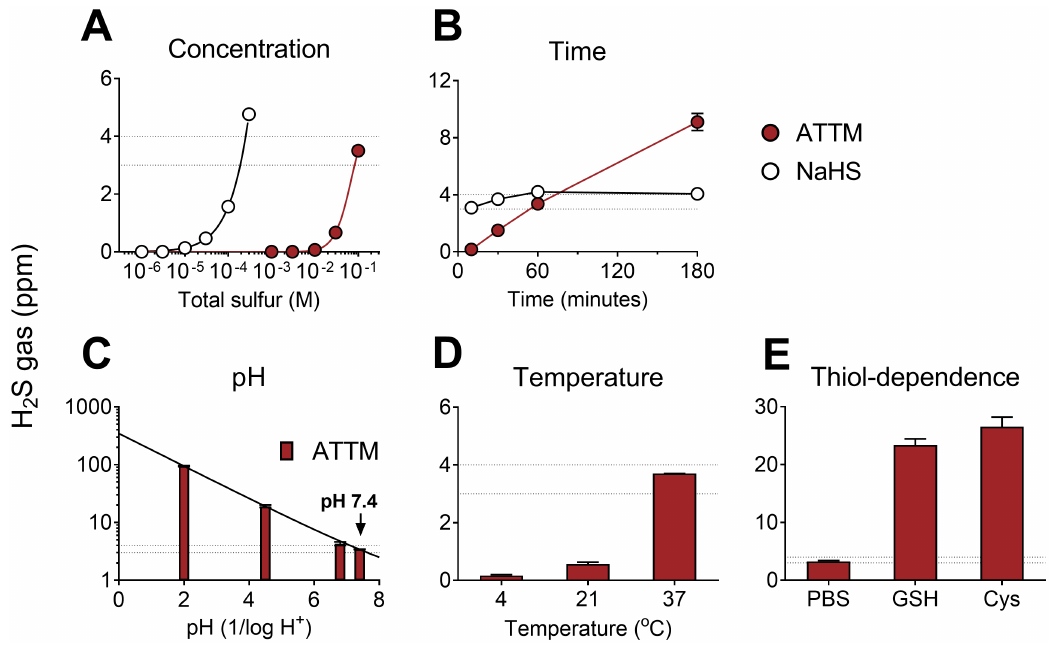
Fig 1. In vitro releaseof gaseous H 2 S from ATTM and NaHS under different environmental conditions. Comparison of ammoniumtetrathiomolybdate (ATTM) and NaHS with changesin (A) concentration and (B) time. In (A), the molarity of each compoundwas adjustedfor equal total sulfur content; drugs were incubatedfor 1 h at physiological pH (7.4) and temperature (37˚C). In (B), fixed concentrations were used: ATTM 100 mM (total sulfur) and NaHS 0.3 mM. The effects of pH, temperature, and the presenceof thiols on H 2 S gas releasedfrom ATTM are shown in (C–E). Here, fixed concentrations (100 mM total sulfur) and incubationtime (1 h) were employed.Peak H 2 S concentrations are displayedin parts per million(ppm). The thiols used were reducedglutathione (GSH; 5 mM) and L-cysteine(Cys; 5 mM). The dotted lines reflect typical H 2 S gas levels (3–4 ppm) obtainedfrom ATTM (100 mM total sulfur) following1 h incubation at normalphysiological pH and temperature. n = 3–6 per